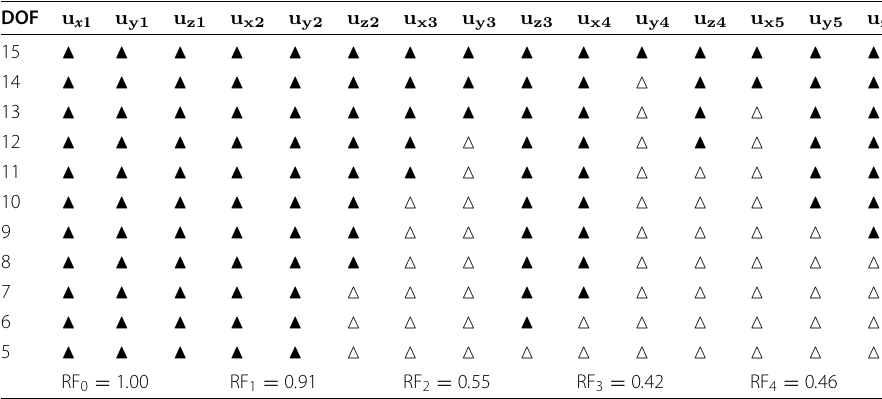
Fig. 9 FE and NN results for 0/90/0, a/h = 10, one layer with ten neurons Table 8 BTD models, 0/90/0, a/h =